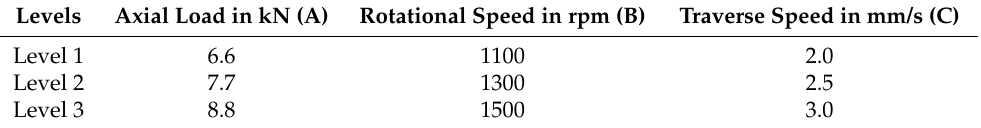
Table 3. Parameters and their corresponding